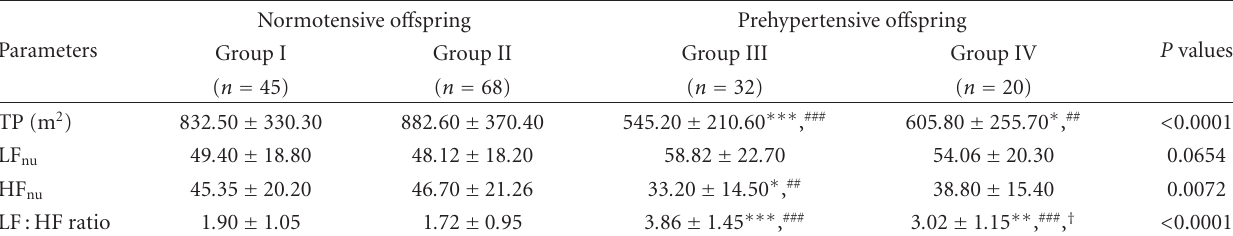
Table 2: Frequency domain indices of HRV recorded in supine position of normotensive and prehypertensive o ff spring of hypertensive parents.